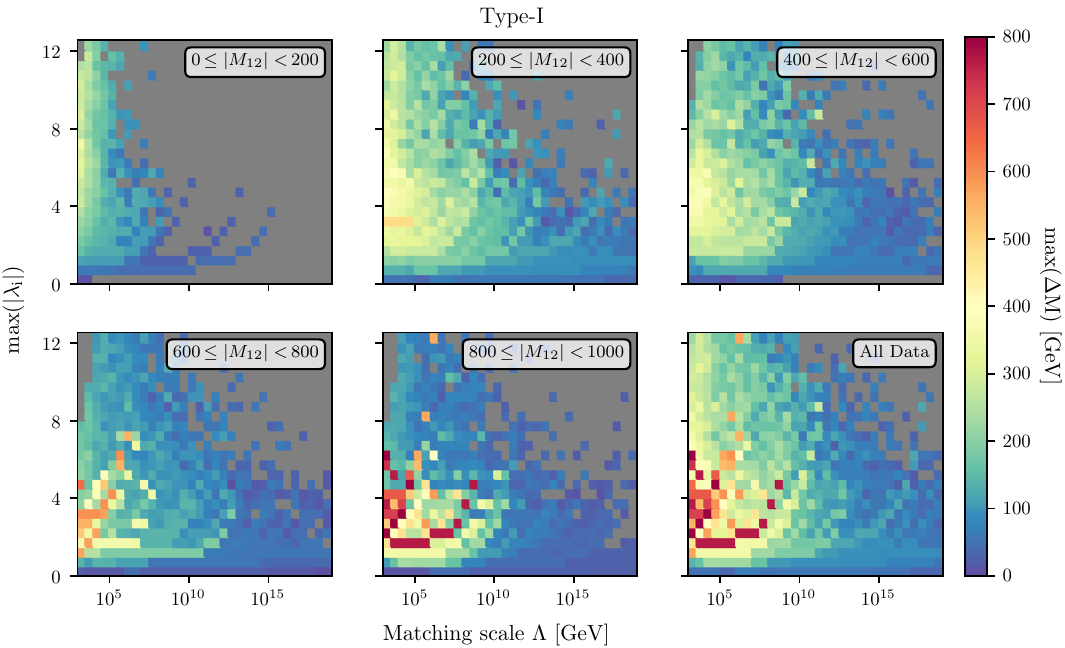
Fig. 4 The maximal mass splitting between the heavy Higgs states (cid:13) M , evaluated at the electroweak scale, as a function of the matching scale (cid:10) and the value of the maximal quartic coupling at (cid:10) . We use the Yukawa scheme of type-I for this